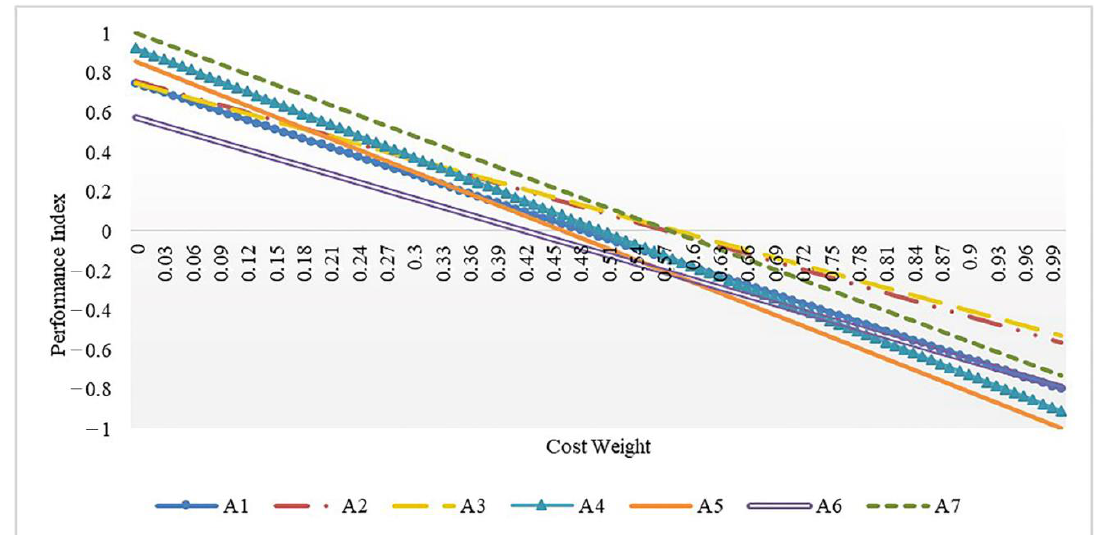
Figure 8. Performance index (PI) variation as a function of the cost weight.